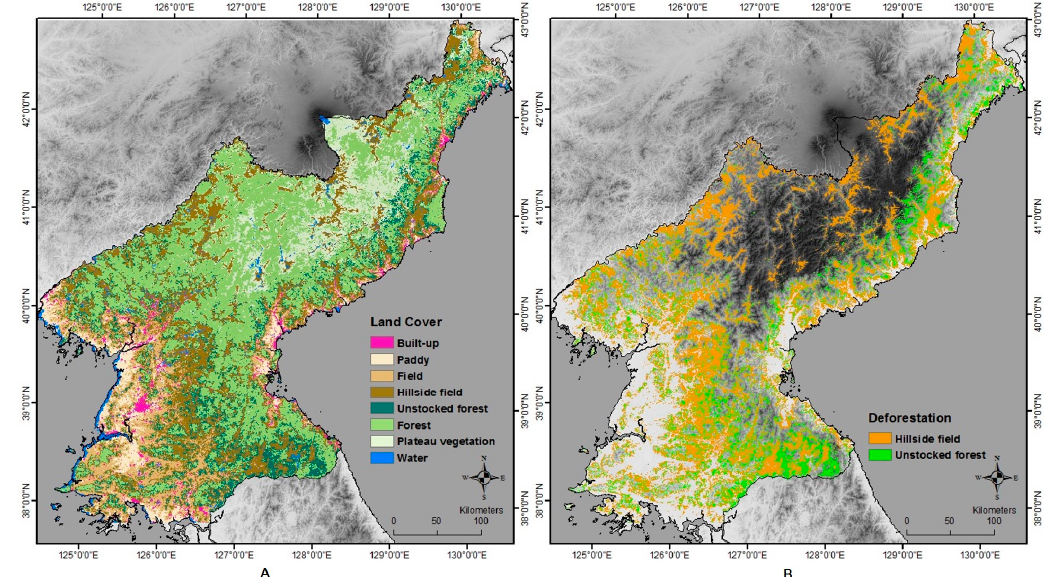
Figure 6. Final forest classification map of North Korea: ( A ) land cover map in North Korea; and ( B ) distribution of deforested land in North Korea.